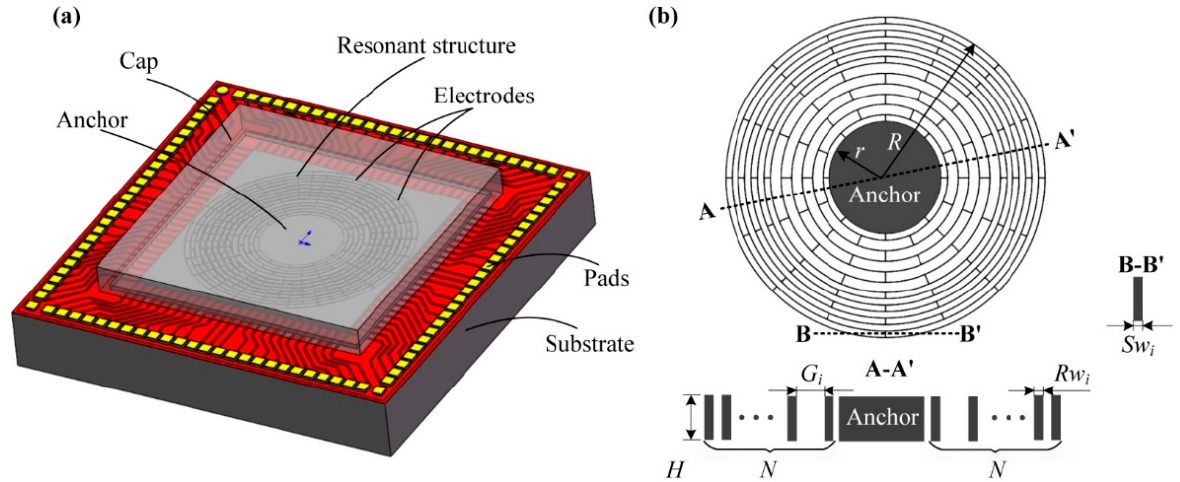
Figure 1. The schematic diagram of the disk MEMS resonator. ( a ) The wafer-level disk MEMS resonator; ( b ) the resonant structure of the disk MEMS resonator.